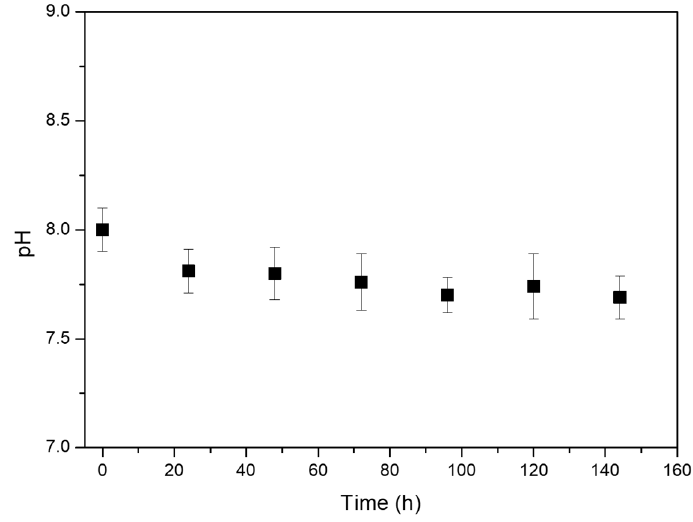
Figure 7. The pH variation during bioelectrical treatment of TCS.